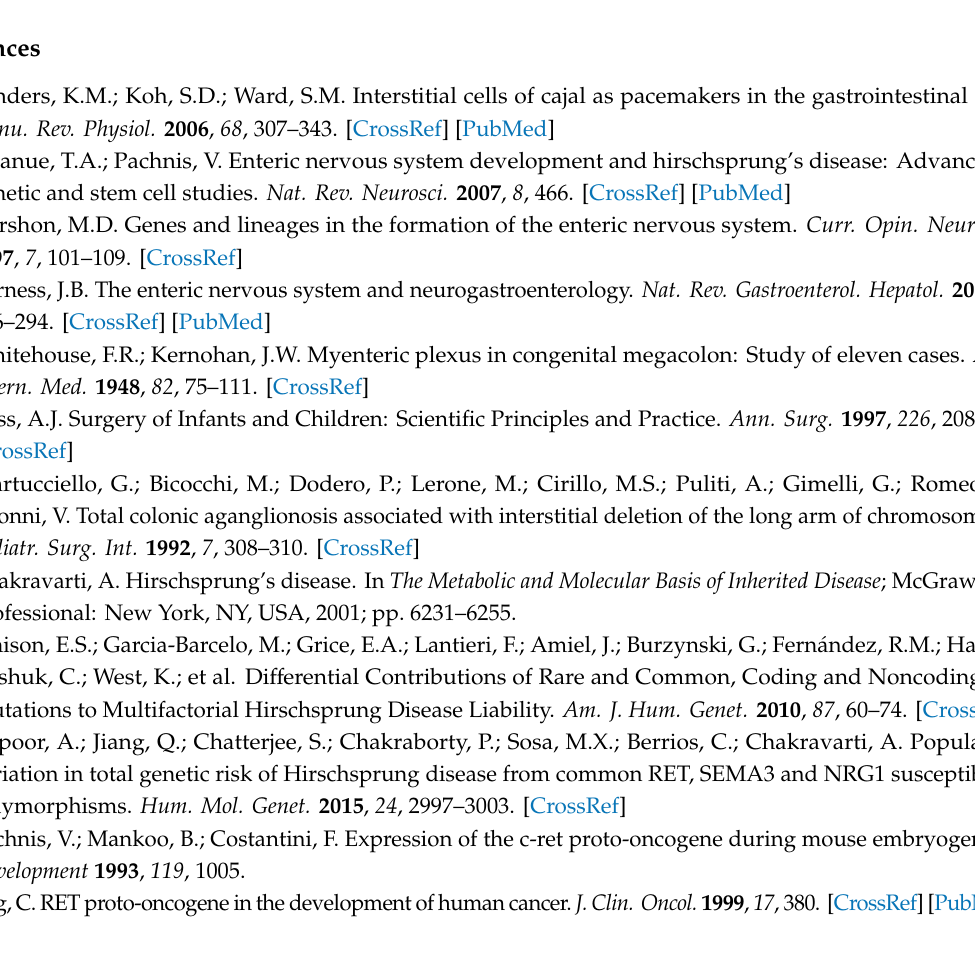
Figure S1: The distribution of genetic codons of bovine RET gene, Figure S2: Linkage disequilibrium plot of two SNPs in bovine RET gene, Figure S3: Graphical tests to explore normality of the residual in Qinchuan group, Figure S4: Graphical tests to explore normality of the residual in Nanyang